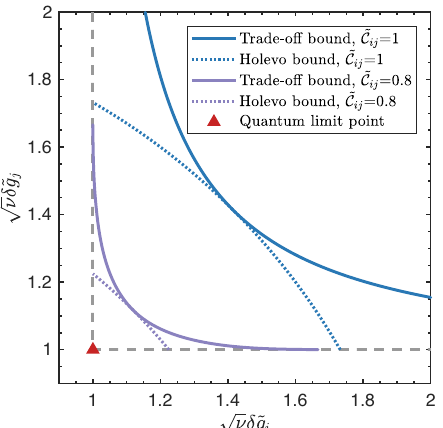
Fig. 8 | Comparison of the trade-off bound and the Holevo CR bound for parameters g 1 and g 2 in our post-selected measurement scenario with HG n pointer. The gray dashed lines are the QCR bounds, where the cross point (red triangle) is the corresponding QL point. The blue solid curve stands for the trade- offbound givenbyEq.(15),andthe bluedottedcurve isthe correspondingHolevo bound with HG n